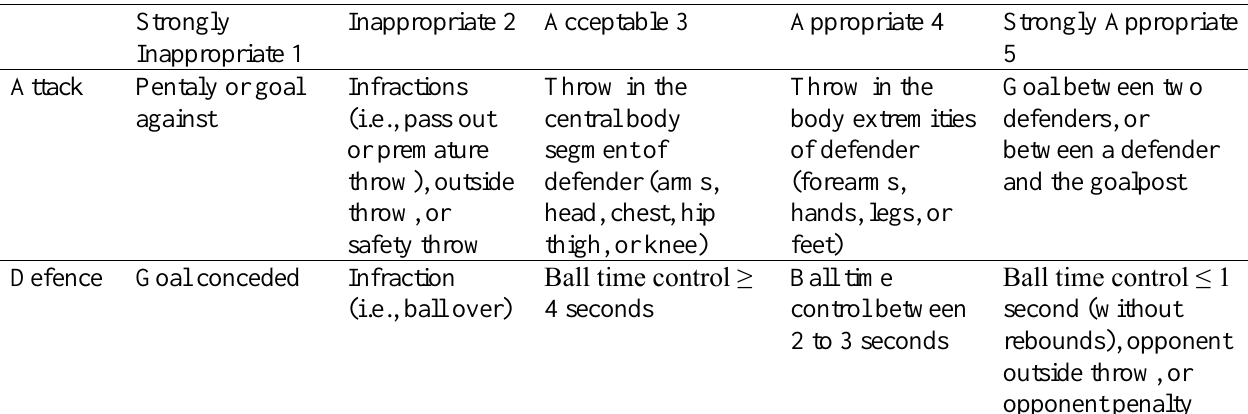
Table 2. Scale of relative quality (Scal-Go) for attack and defence phases. Strongly Inappropriate 2 Acceptable 3 Appropriate 4 Strongly Appropriate Inappropriate 1 Attack Pentaly or goal Infractions Throw in the against (i.e., pass out central body or premature segment of throw), outside defender (arms, throw, or head, chest, hip safety throw thigh, or knee) Defence Goal conceded Infraction Ball time control ≥ (i.e., ball over) 4 seconds Note : safety throws were considered situations when players instead of exceeding 10 seconds and to commit a penalty they throw the ball outside deliberately (Morato et al., 2017).